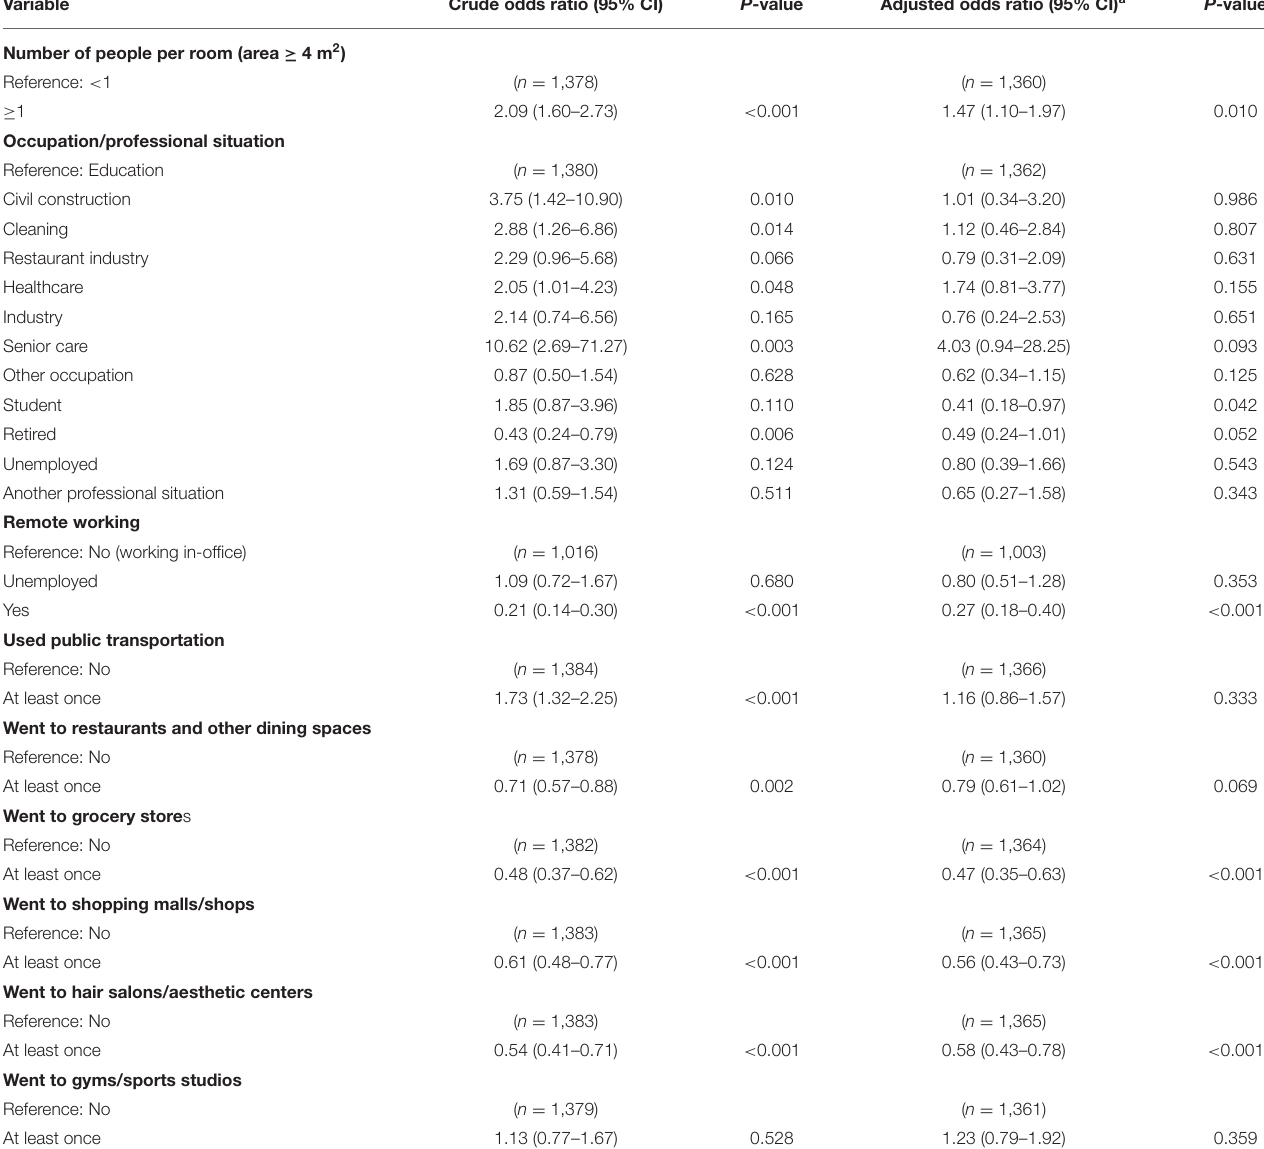
TABLE 4 | Risk of infection of SARS-CoV-2 among cases and controls from the Lisbon and Tagus Valley Region in September and October 2020. Variable Crude odds ratio (95% CI) P -value P